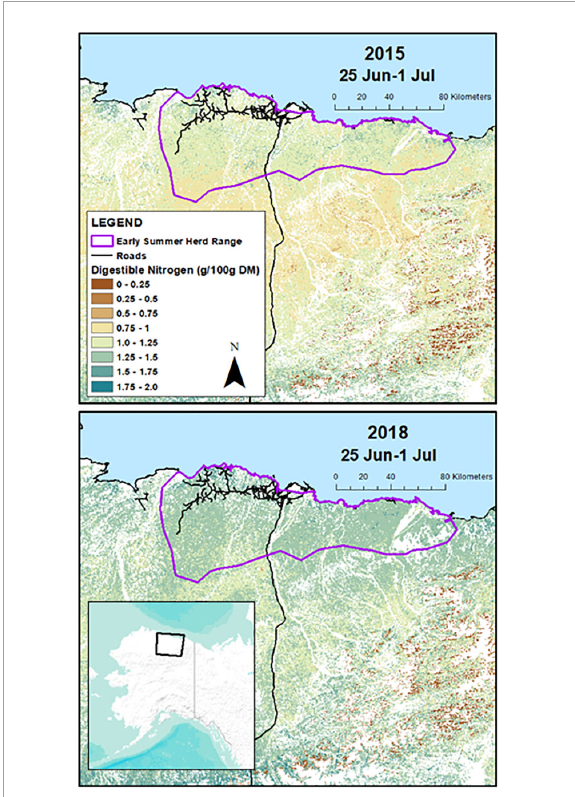
FIGURE1 Prediction area for weekly summer forage conditions in the Central Arctic Caribou Herd on the North Slope of Alaska. The top panel depicts estimates of digestible nitrogen 25 June–1 July in 2015, a year which had early spring phenology, and the bottom panel depicts digestible nitrogen the same week in 2018, a year with late spring phenology. The purple line shows the early summer herd range polygon (16 June–15 July) where caribou were located during the period that digestible nitrogen is